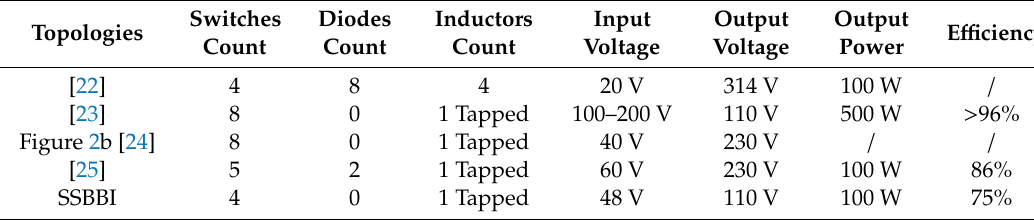
Table 10. Comparison of the SSBBI with the state of the